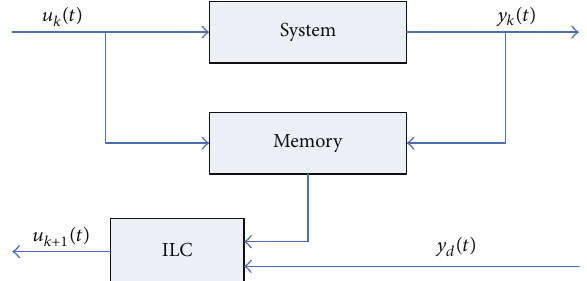
Figure 1: The basic idea of ILC.